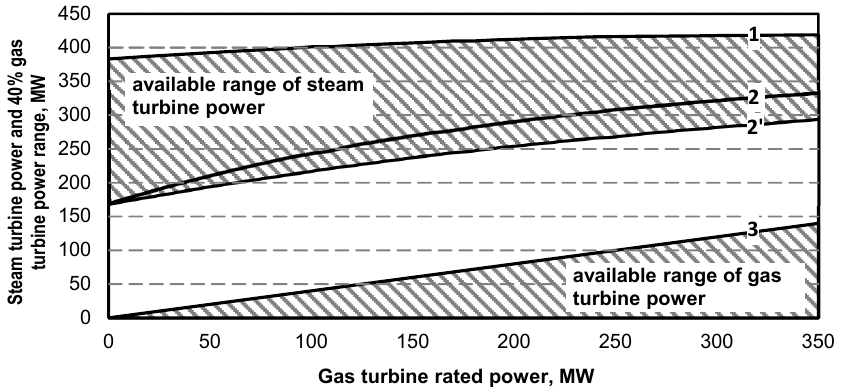
Figure 15. Steam turbine power as a function of gas turbine rated power: 1 — maximum fixed stream of 319.4 kg/s fresh steam fed to steam turbine; 2 — minimum steam boiler output of 133.3 kg/s and gas turbine operating at a rated power, 2’ — minimum steam boiler output of 133.3 kg/s and gas turbine operating with 60% of its rated power, 3 — 40% of gas turbine rated power.